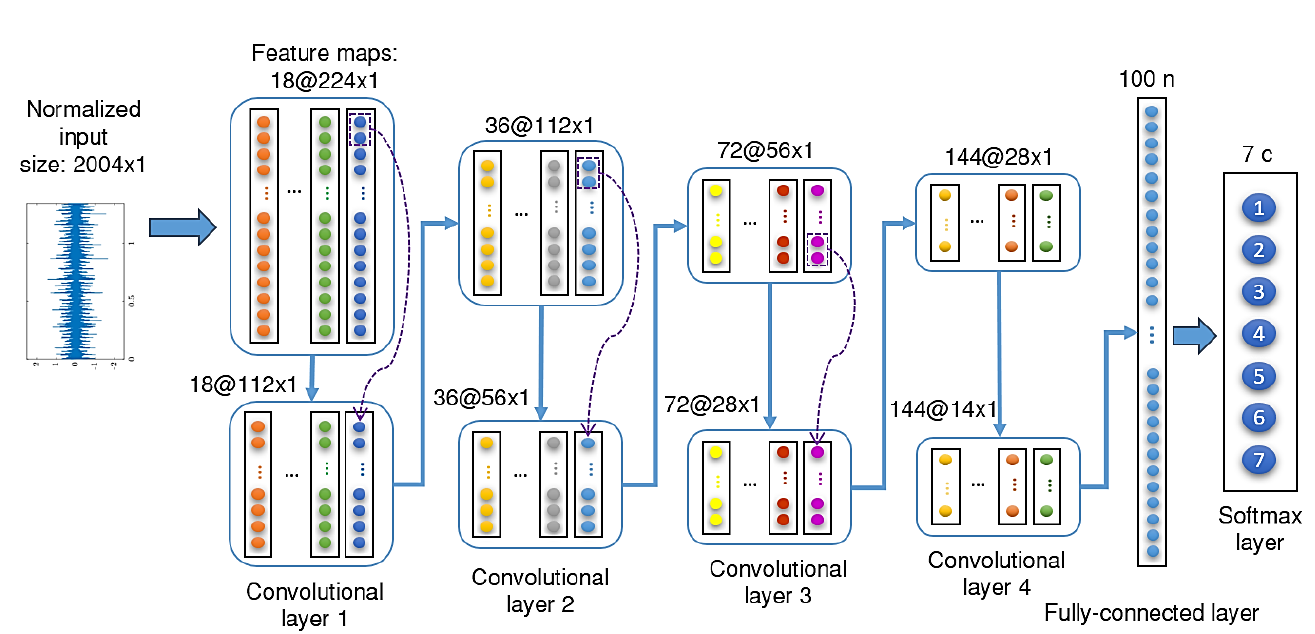
Figure 3. Internal structure of 1D-CNN network. Table 3. Hyper parameters configuration for the 1D-CNN.